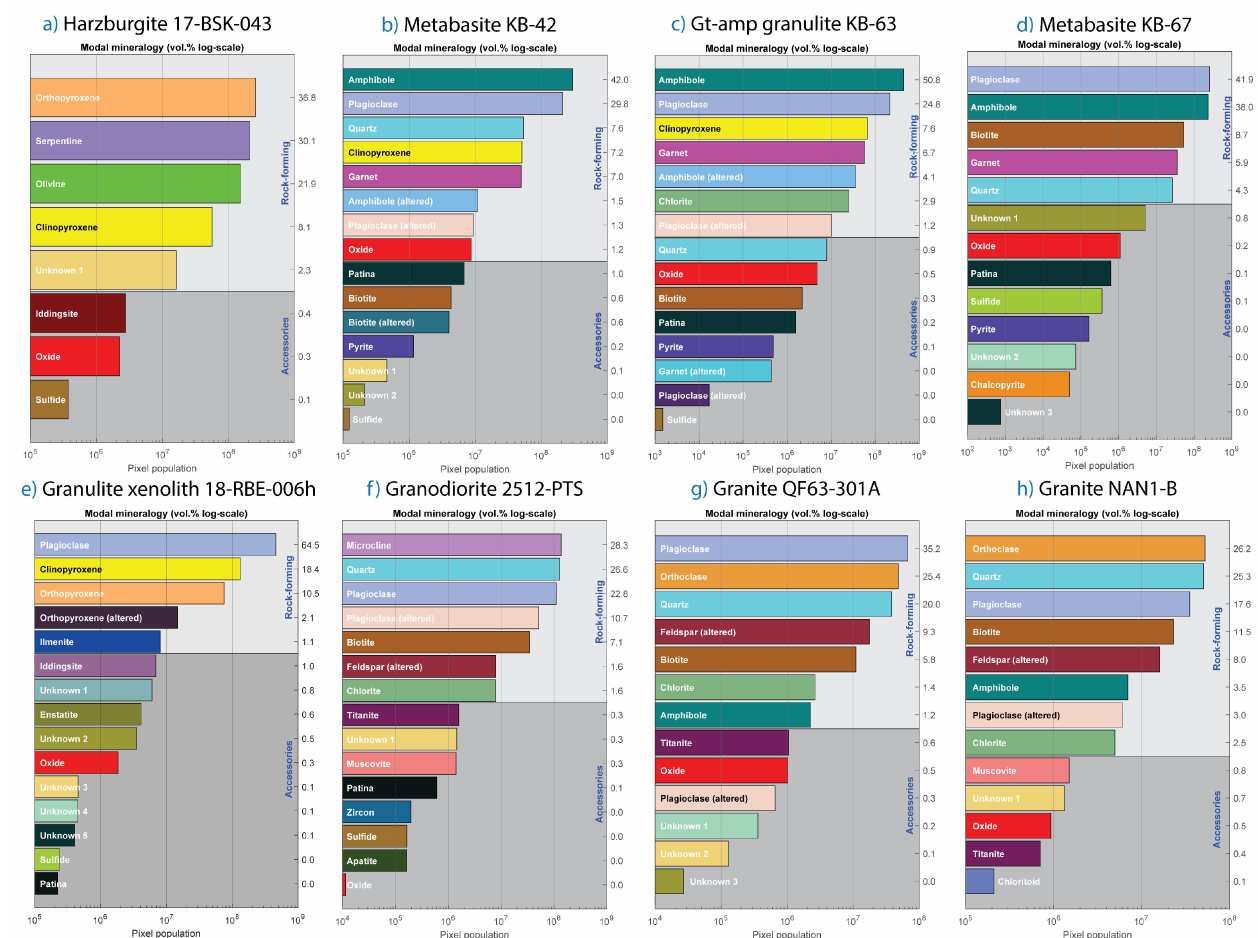
Figure 14. Legends and volume (%) modal abundance plots for the phase maps shown in Figure 13. The X-axis shows the pixel population (logarithmic) for easy comparison between the order of magnitude, whereas the Y-axis shows the conversion to volume % values for each phase. Phases for which iden- tification was equivocal were tagged as ‘unknown’ or were named with broad mineral family names (oxide, sulphide, altered, etc.). The identification could be refined by adding chemical